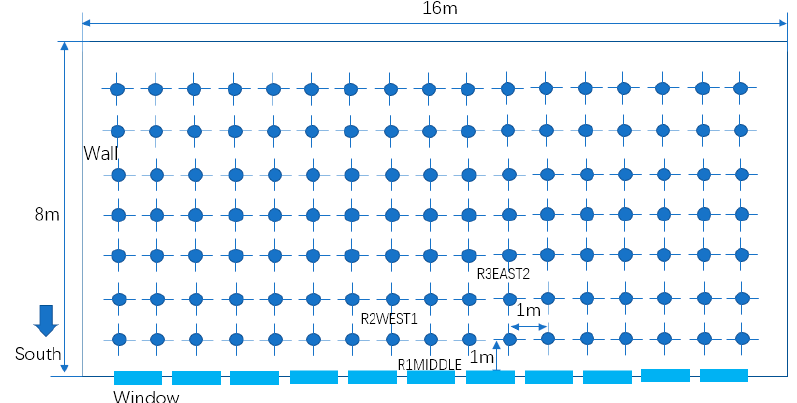
Energies 2022 , 15 , 4931